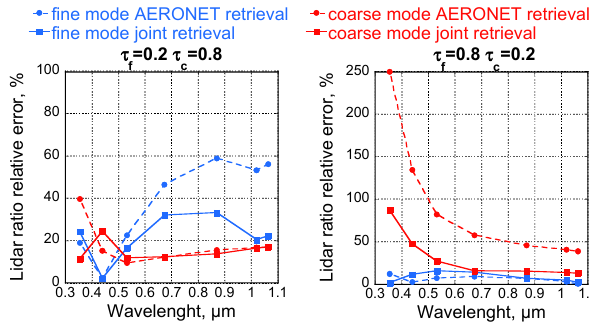
Fig. 11. Retrieval errors of lidar ratio with and without accountancy for lidar